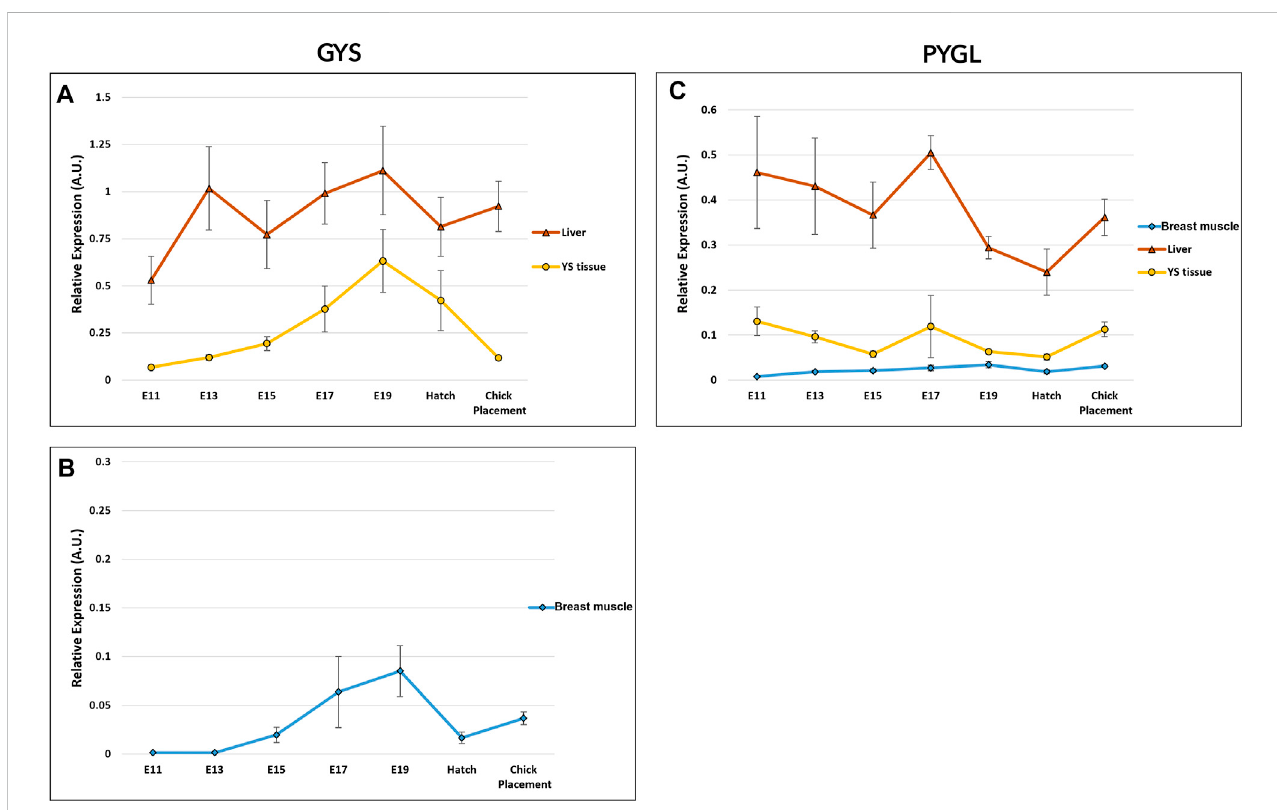
FIGURE 6 Dynamic expression of genes involved in glycogen synthesis and breakdown. (A, B) Glycogen synthase (GYS*) catalyzes the rate-limiting step in the synthesis of glycogen; (C) Glycogen phosphorylase L (PYGL), catalyzes the release of glucose- 1 -phosphate from glycogen. As derived from a two-way ANOVAfollowedbyTukey ’ sHSDtest,thefactoroftissuewasfoundtobesigni fi cantlydifferentinGYSandPYGL(highestintheliver,meanintheYStissueand lowest in the breast muscle). The factor age was also signi fi cant, as E 1 9 was highest in GYS and E17 was highest in PYGL ( p < 0.05), n = 6 per day. *Two variants were used for glycogen synthase gene; (A) GYS2 in the liver and YS tissue and (B) GYS one in the breast muscle.